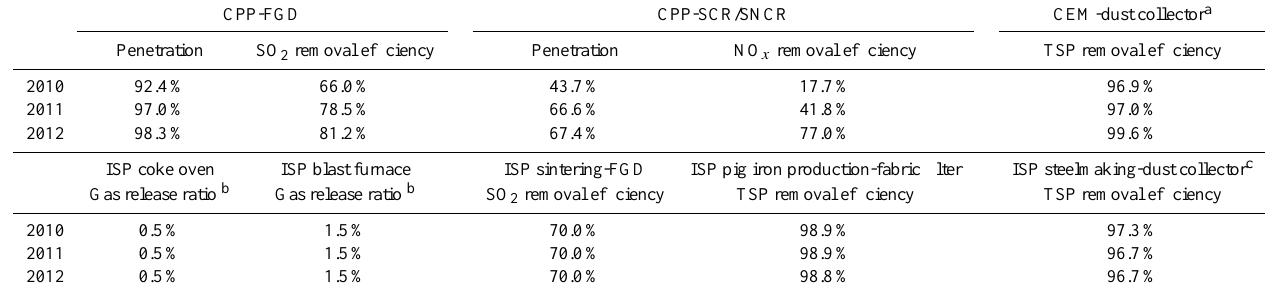
Table 1. The capacity penetrations, average removal efficiencies of APCDs, and flue gas release ratios for key sources in